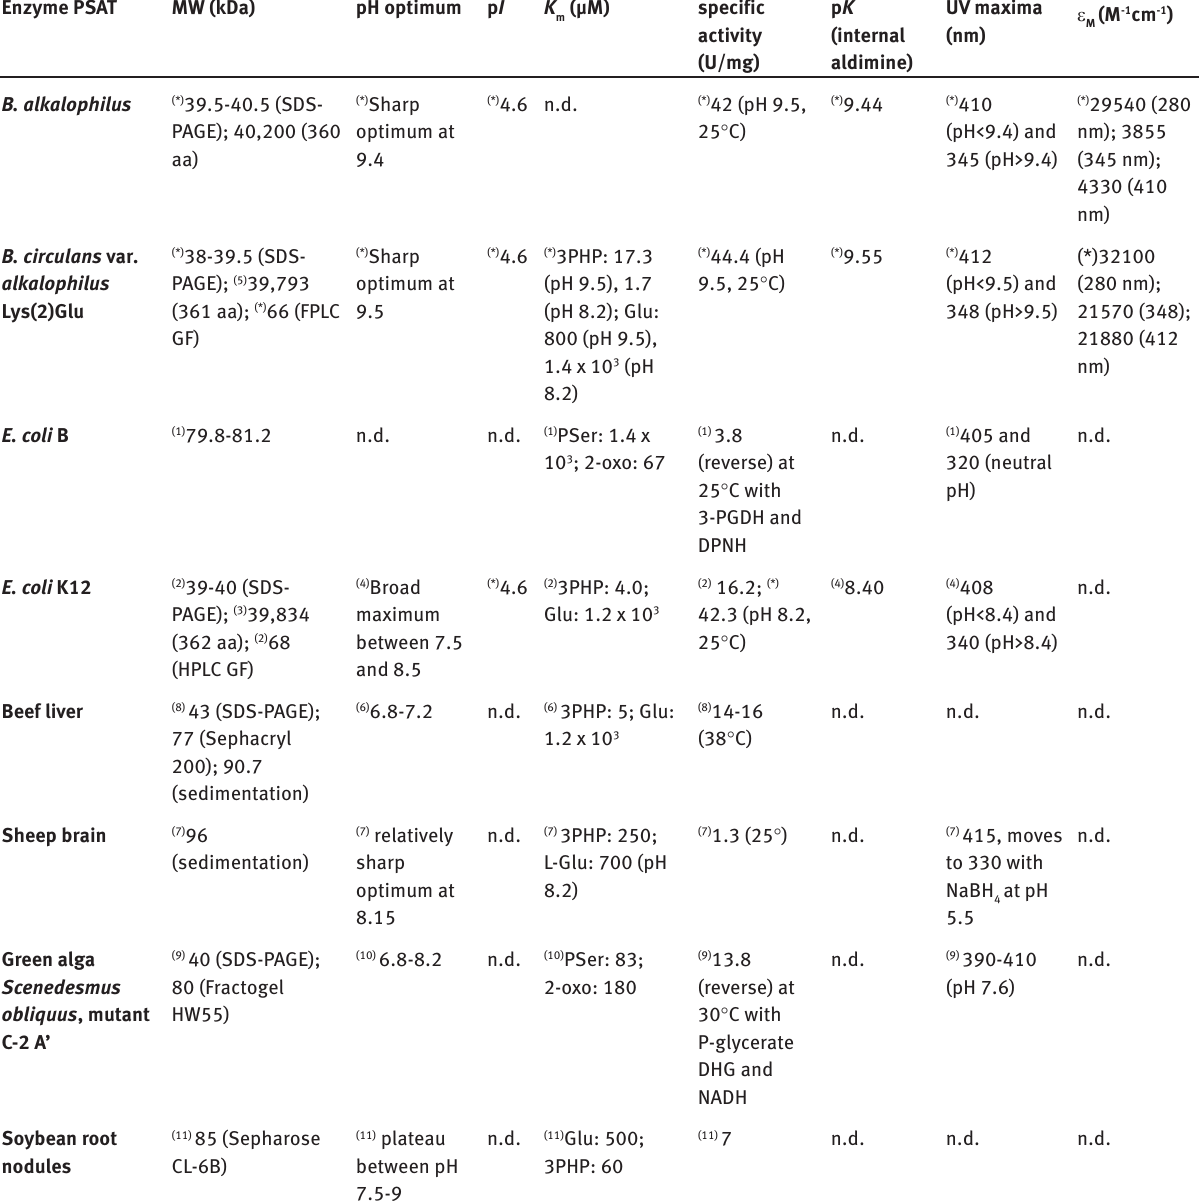
Table 3: Comparison of properties of phosphoserine aminotransferases from various sources. The data marked with asterisks were determined with the near-homogenous recombinant enzymes of the present study. Upper numeral indexes refer to the source of the data: